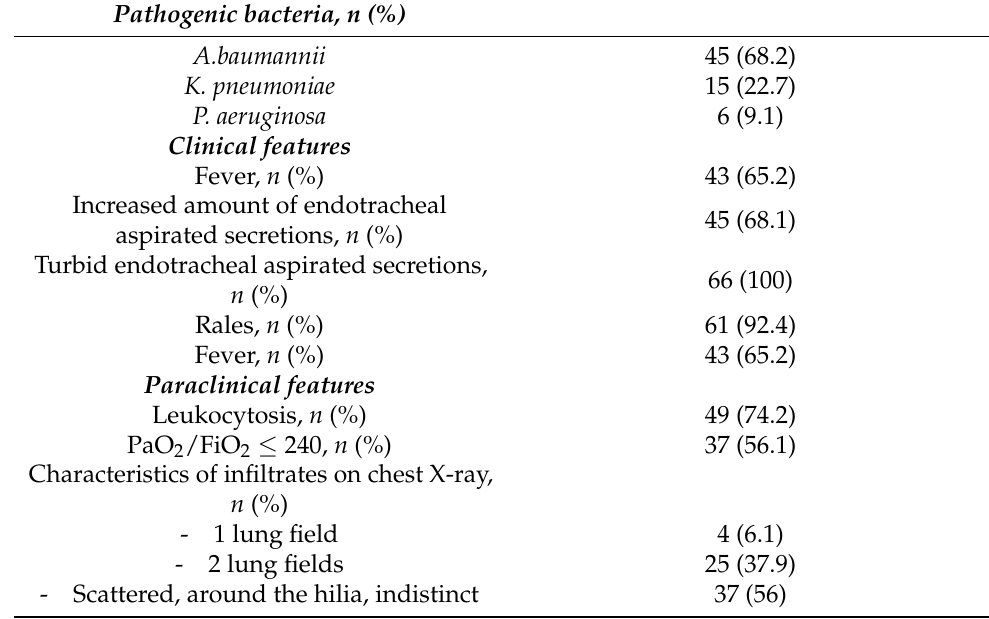
Table 3. Pathogenic, clinical and paraclinical characteristics of the patients in the study ( n =